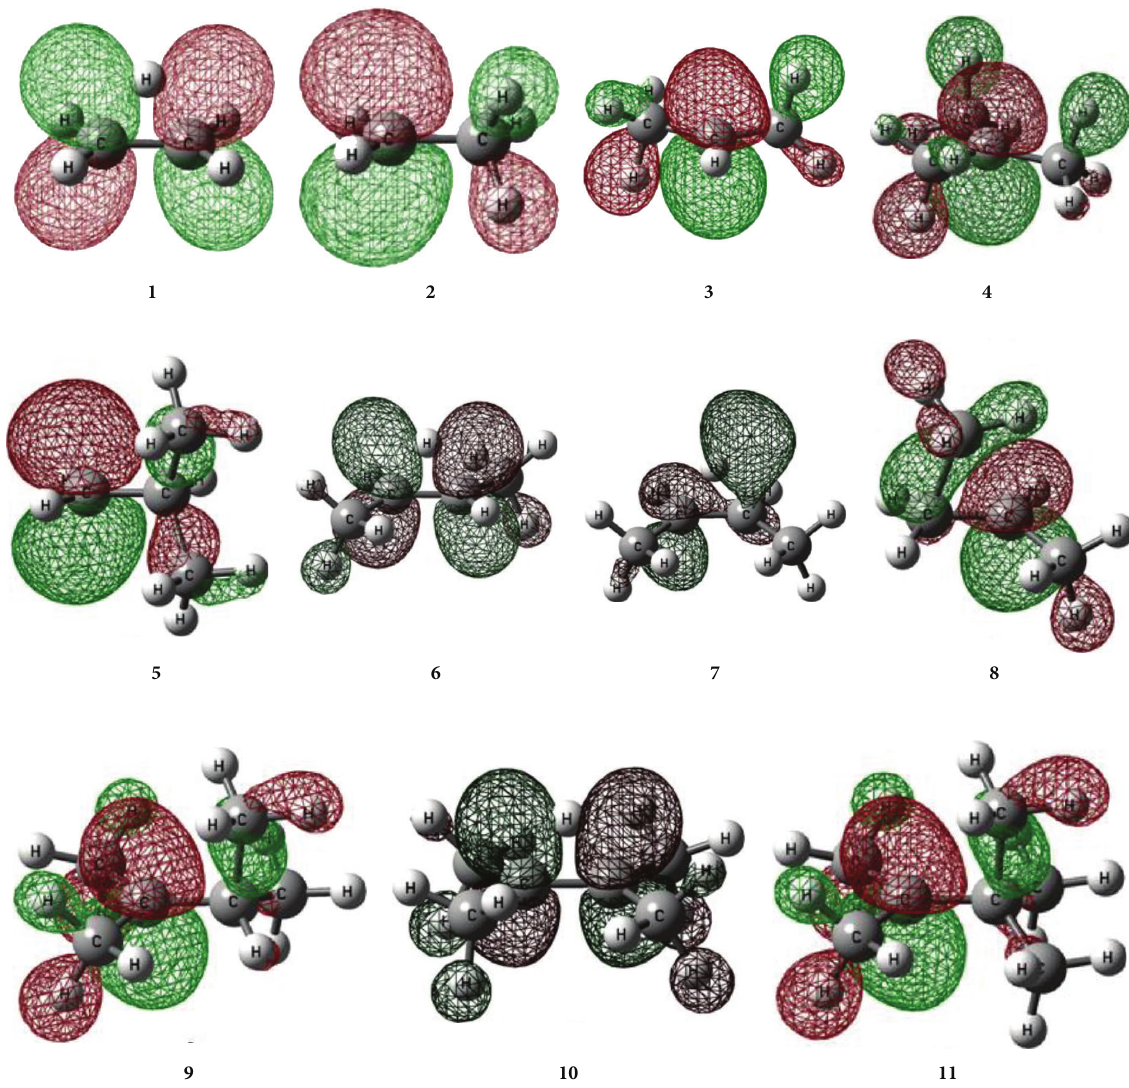
Figure 3: LUMO orbitals of ethyl cations 1 – 11